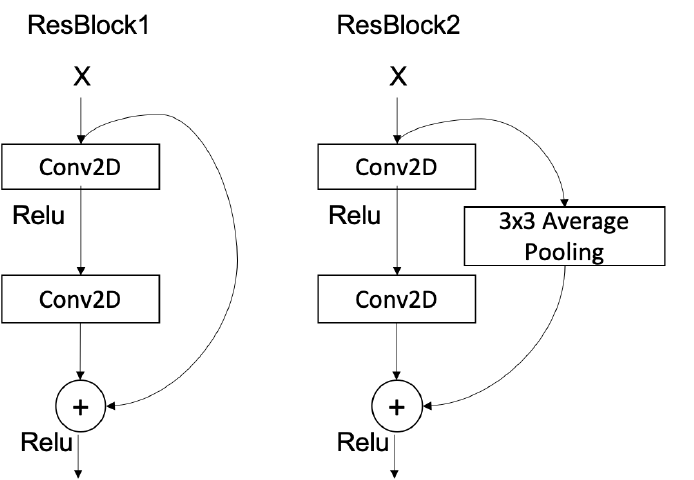
Figure 7. Two types of residual blocks are used in the baseline ResNet. ResBlock1 has the skip connection directly from the input of the block to the addition operation at the output, while ResBlock2 modifies the input x by an average pooling operation over a 3 × 3 window.